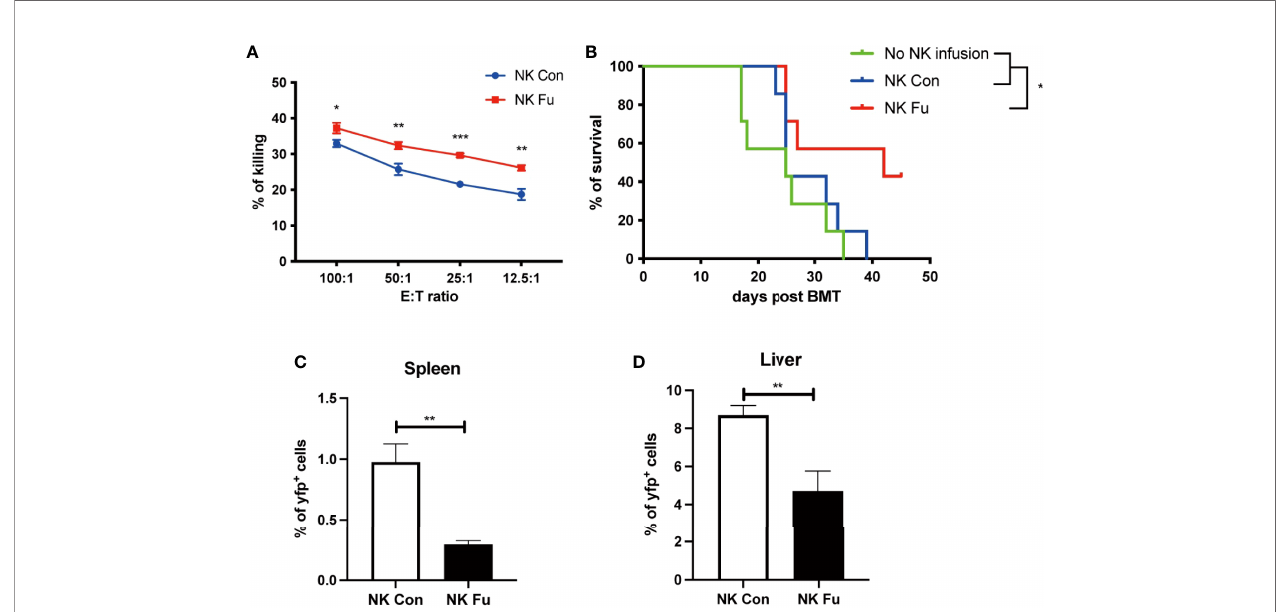
FIGURE 4 | Fucosylated donor NK cells have enhanced GVT effect against B cell lymphoma. (A) Fucosylated NK cells and control NK cells were cocultured with A20 lymphoma cells at different ratios for 6 hours, respectively. Cytotoxicity of NK cells were evaluated by the apoptosis of yfp + lymphoma cells as detected by fl ow cytometry. (B) BALB/c recipients were lethally irradiated and transplanted of 5x10^6 BM cells together with 5×10^6 A20- luc +/ yfp cells. Recipients were transferred with or without 1x10^6 control NK cells or fucosylaed NK cells, respectively. Survival of recipients were monitored (n = 7-9 mice per group). (C, D) Proportions of yfp positive lymphoma cells in the spleen and liver were detected by fl ow cytometry 7 days post transplantation. Data are representative of three independent experiments and presented as mean ± SD. * p < 0.05; ** p < 0.01; *** p <